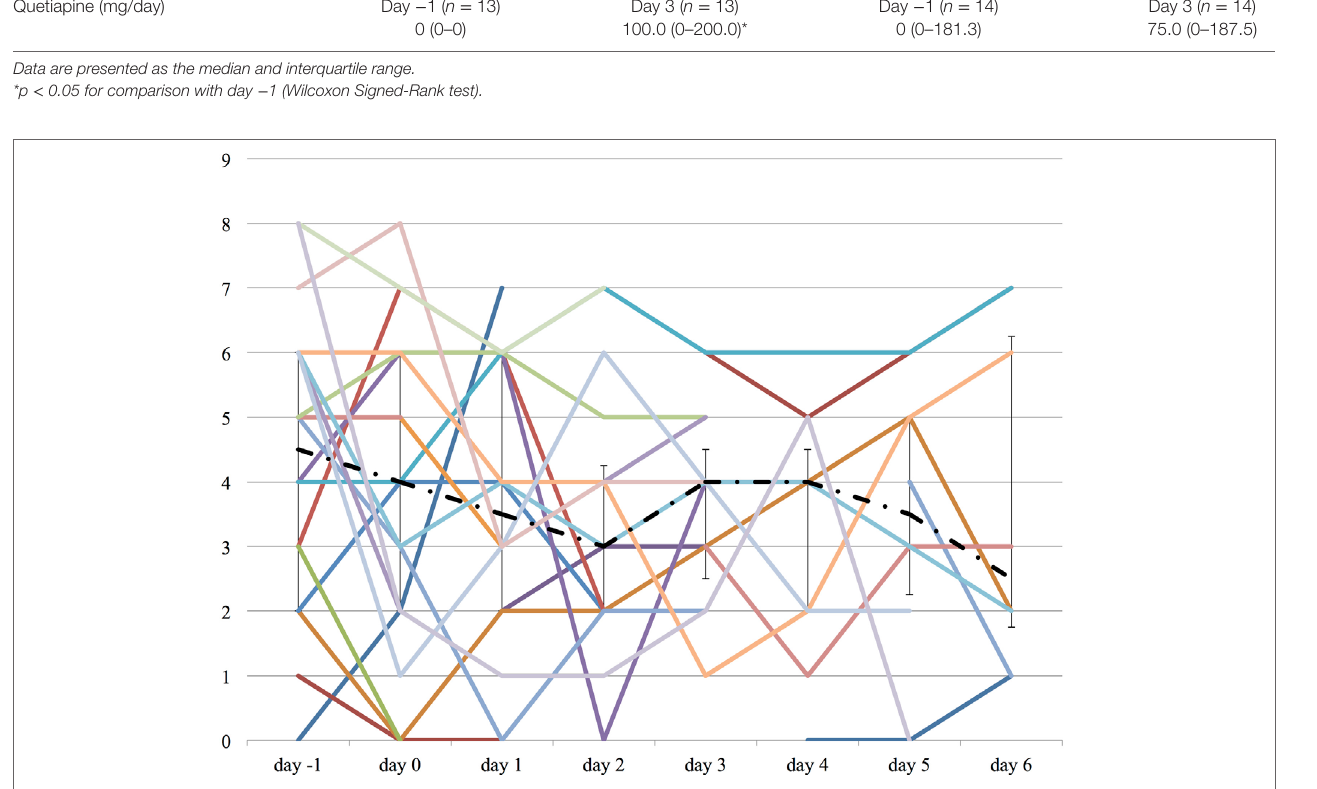
FigUrE 6 | The worst intensive Care Delirium Screening Checklist (iCDSC) score on each day from day − 1 to day 6 . The vertical axis represents ICDSC score of each patient. The dashed line represents the median ICDSC score, and the range represents the interquartile